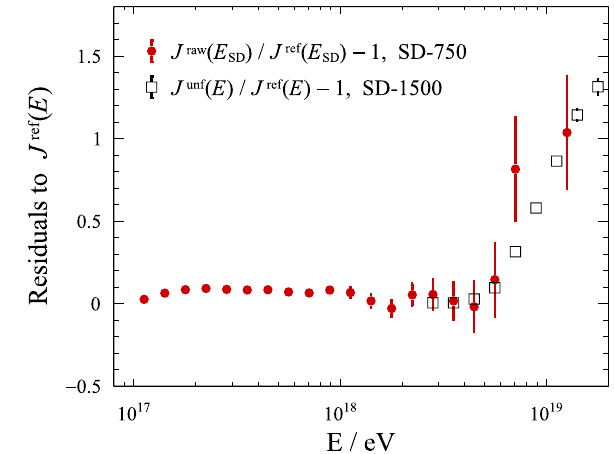
Fig. 10 The bias of the energy assignment for the SD-750 was studied using Monte Carlo simulations, weighted according to the GSF model [41]. The ratio of the assigned and expected values as a function of energy are shown (red circles) along with the parameterization (blue line) given in Eq. (9) Table 5 Best-fit parameters for the relative energy bias of the SD-750, b SD ( E ) , given in Eq. (9) Parameter